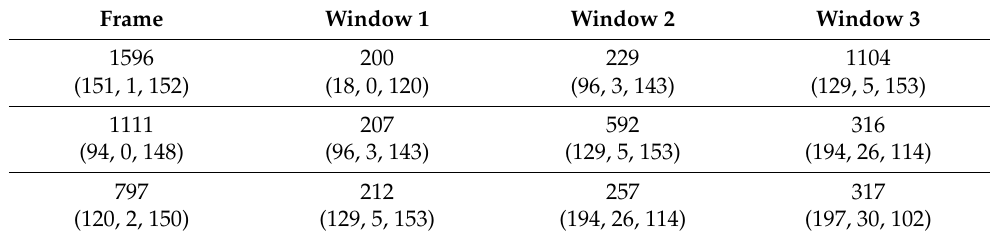
Table 3. Color distribution of segmented